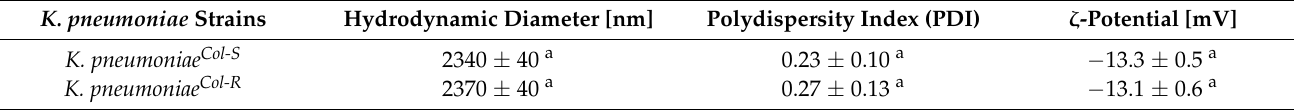
Table 1. Dynamic light scattering results of colistin-susceptible ( K. pneumoniae Col-S ) and laboratory-induced high-level colistin-resistant ( K. pneumoniae Col-R ) Klebsiella pneumoniae